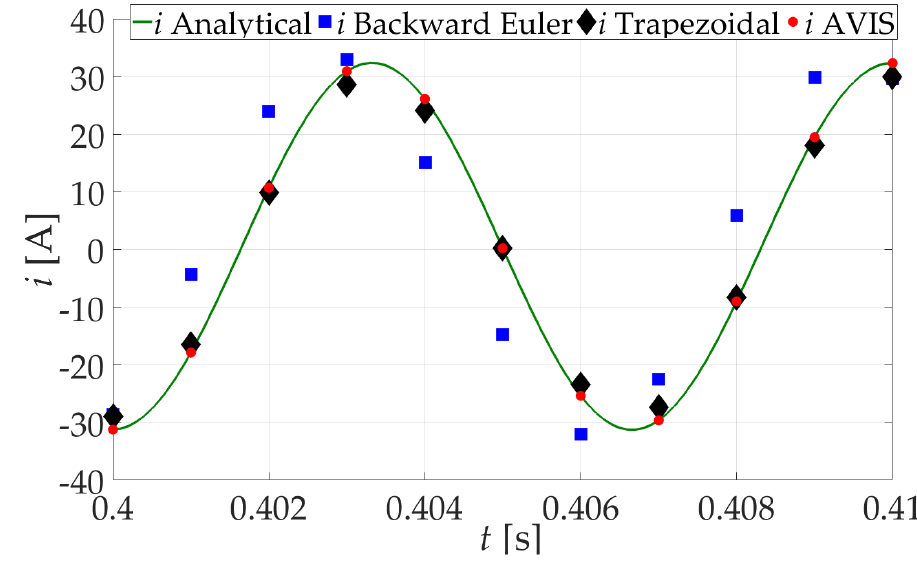
Figure 8. A section of the current waveform after connecting the RL double socket to a voltage source with a frequency of 150